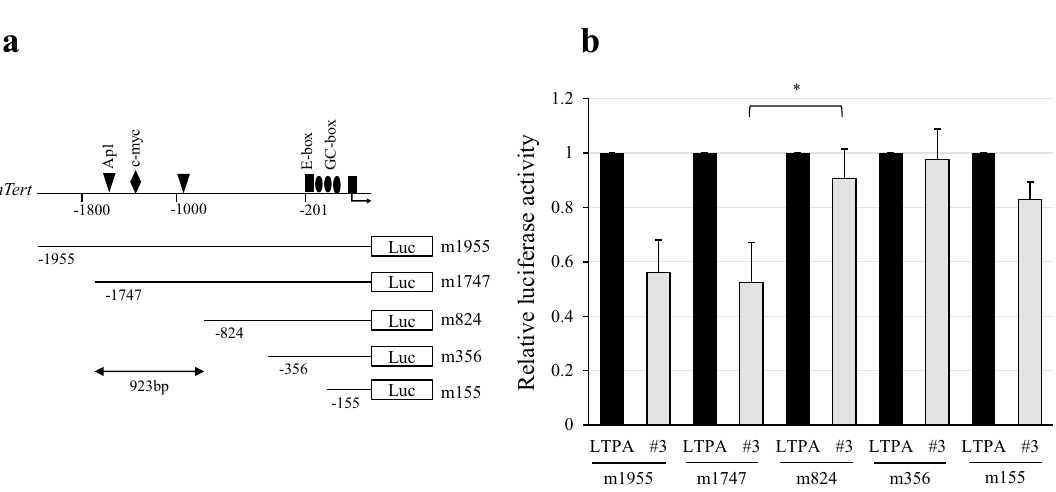
Figure 4. Identification of an mTert suppressor region on 3p21.3 by transfer of truncated chromosomes. ( a ) PCR analysis of truncated chromosomes in A9 cells using STS markers for chromosome 3. Full-length gels of the PCR analysis are presented in Supplementary Fig. S1. Fluorescence in situ hybridization analysis of ( b ) LTPA#3delp22-pter and ( c ) LTPA#3delp21.3-pter cells. FITC-labeled RP-6 234N4 pPAC4 that included the 3p21.3 region and rhodamine-labeled human COT-1 DNA were used as probe DNA. The arrowhead indicates a transferred truncated human chromosome 3. ( d ) Quantitative RT-PCR analysis of relative mTert mRNA expression levels in LTPA, LTPA#3, LTPA#3delp22-pter, and LTPA#3delp21.3-pter cells. The mRNA expression of mGapdh was used as the internal control. Data are presented as means ± S.E. of three independent experiments (** P < 0.001).